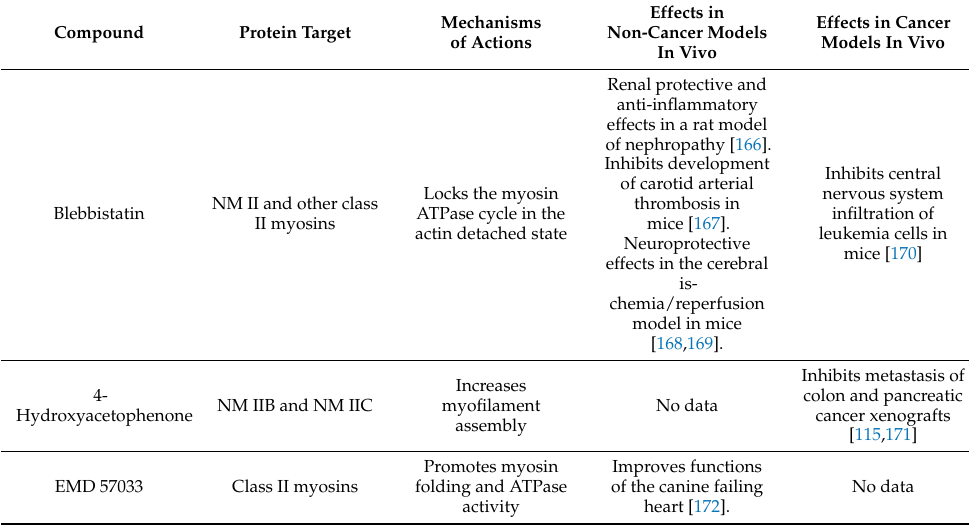
Table 2. Cellular targets and biological effects of the pharmacological modulators of conventional and unconventional